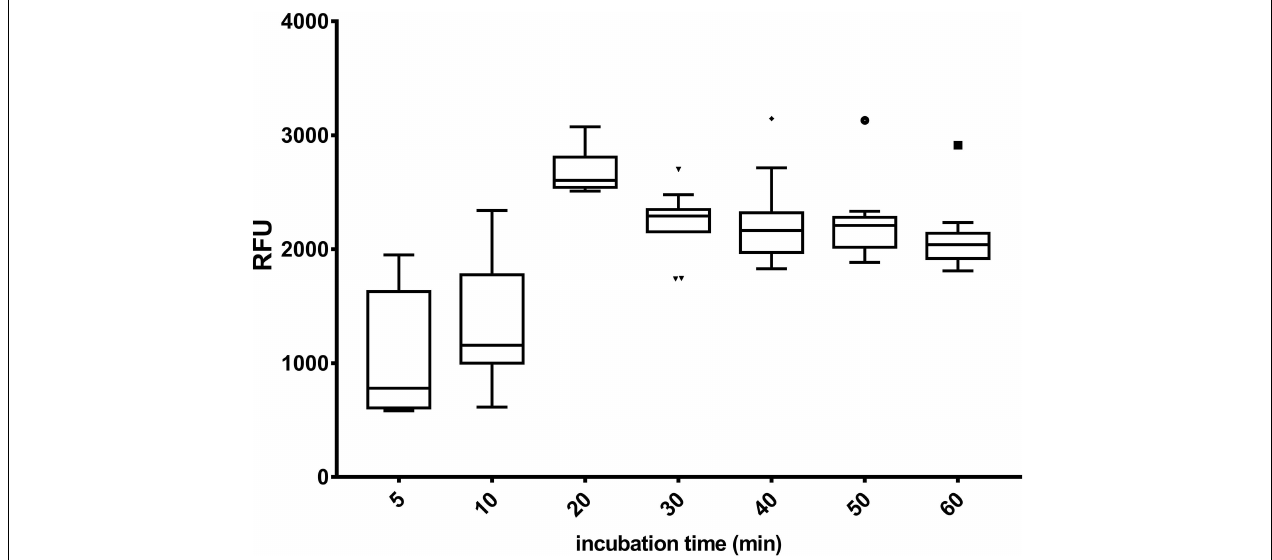
FIGURE 2 | Boxplot of Nile red fluorescence measurements, independent of solvent used, against incubation time. The analysis included cells of M. guilliermondii BI281A (OD 600 nm = 0.03). The box represents 50% of the data, the line inside the box indicates the median ( n = 3), the confidence interval includes the box and whiskers (95% of the data). Fluorescence readings obtained from glycerol 50% (v/v) were marked as outlier in the boxplot and were not taken into account in the statistical analysis. OD, optical